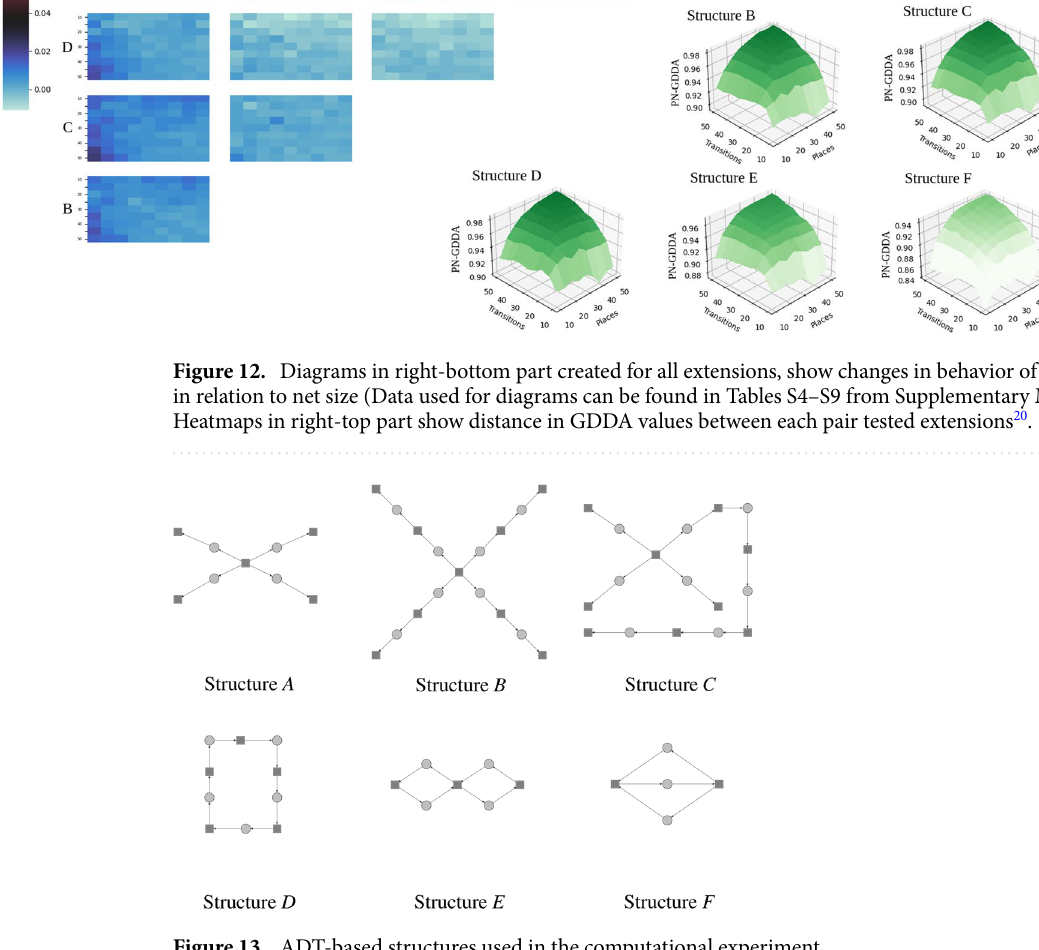
E were connected by a single arc with the rest of the generated net. For case F we decided Fig. 13. Structures A − to connected the structure by 2 arcs and check its impact on PN-GDDA.